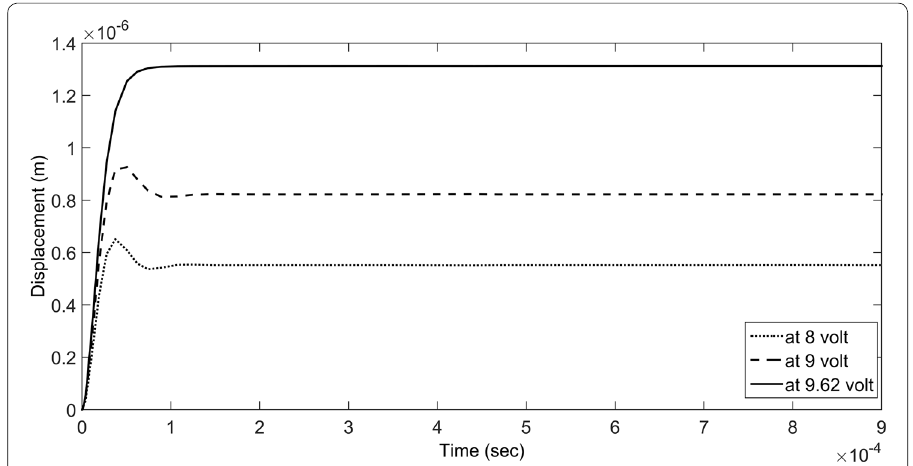
Fig. 3 Actuator behavior at different voltages